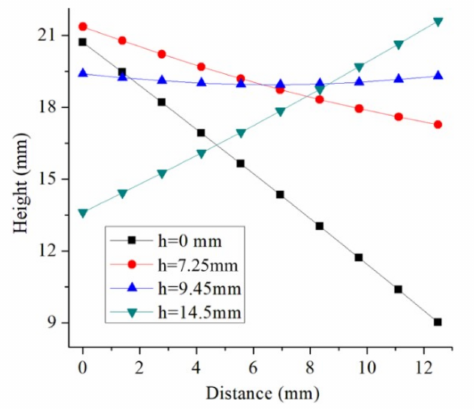
Figure 10. Deformation profiles on Path